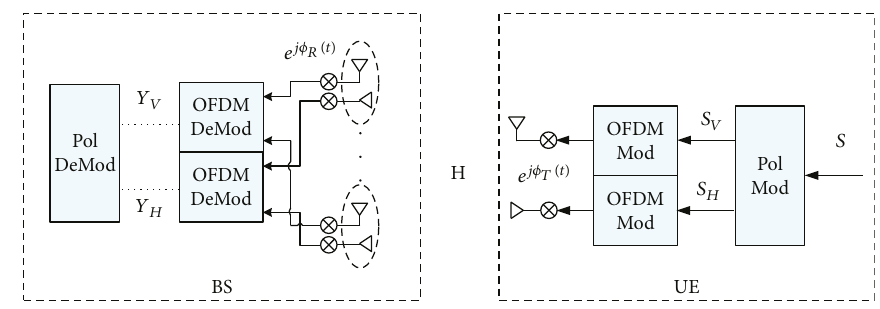
Figure 1: SU-massive MIMO-OFDM uplink system exploiting PM.